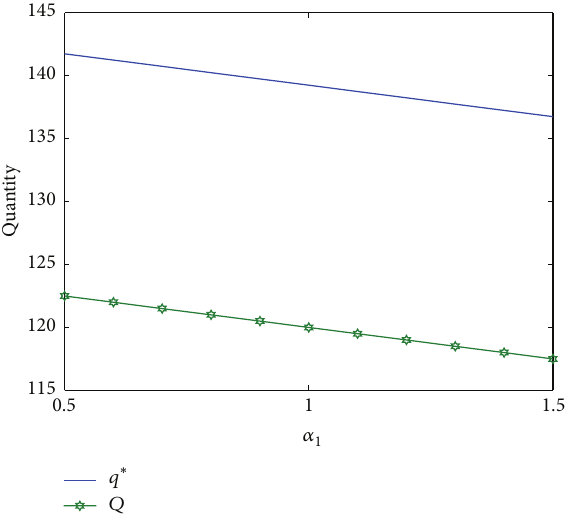
Figure 10: Impact of 𝛼 1 on ordering quantity under demand certainty and uncertainty.